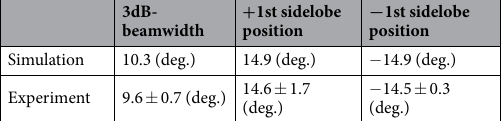
Table 1. Radiation pattern characteristics in the E-plane.